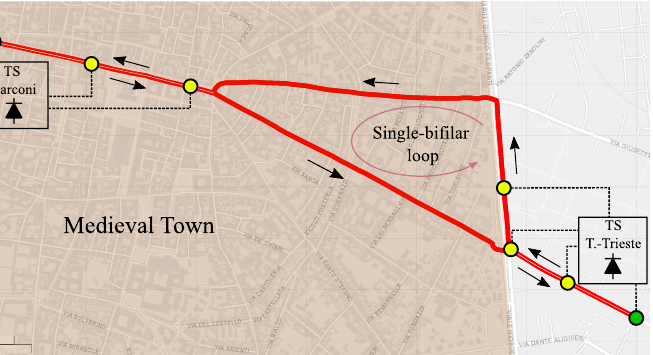
Figure 1. Topology of FS MTT. Green and yellow circles represent the location of feeders and reinforcement feeders, respectively. Dashed lines represent the connection with the TSs. Arrows indicate the trolleybuses’ travel direction.